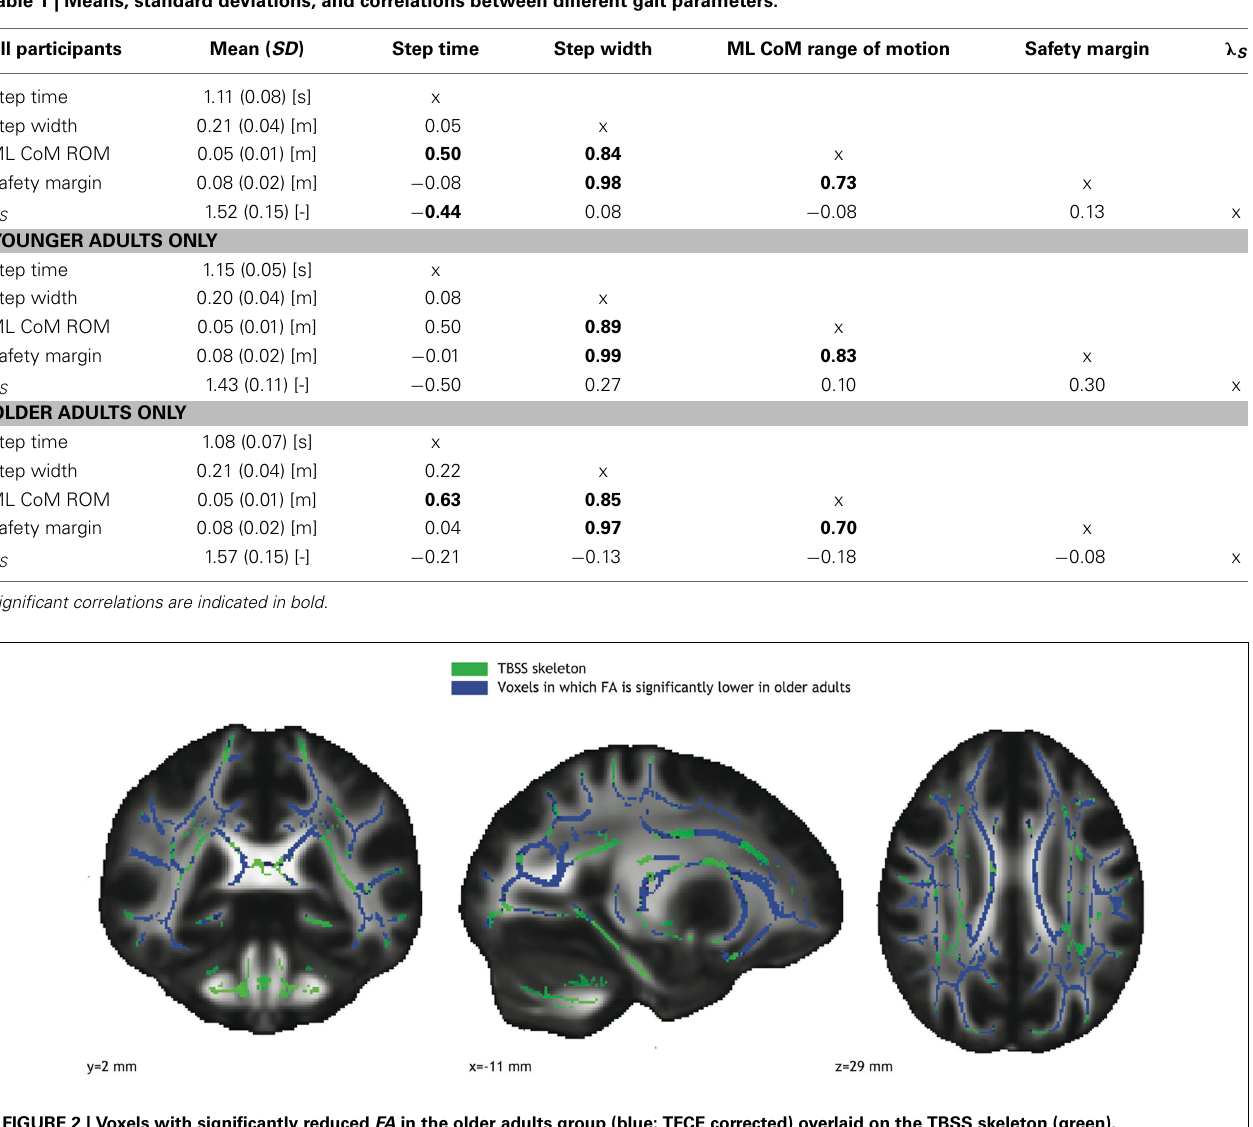
(JHU probability map indicated in blue in Figure 4 ) and left ante- rior thalamic radiation (JHU probability map indicated in green in Figure 4 ). The correlation between F1 and safety margin